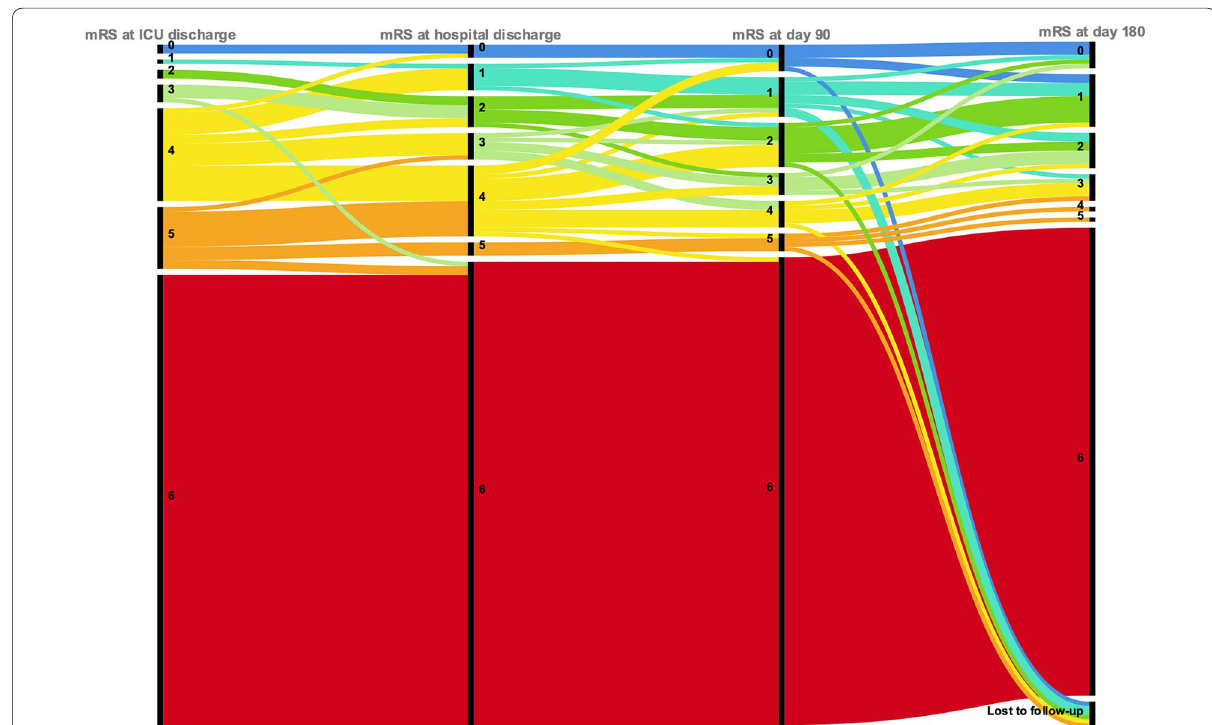
Fig. 2 Alluvial diagram of patients’ outcome at ICU and hospital discharge, at day 90 and 180 after CA. ICU intensive care unit, CA cardiac arrest, mRS modified Rankin